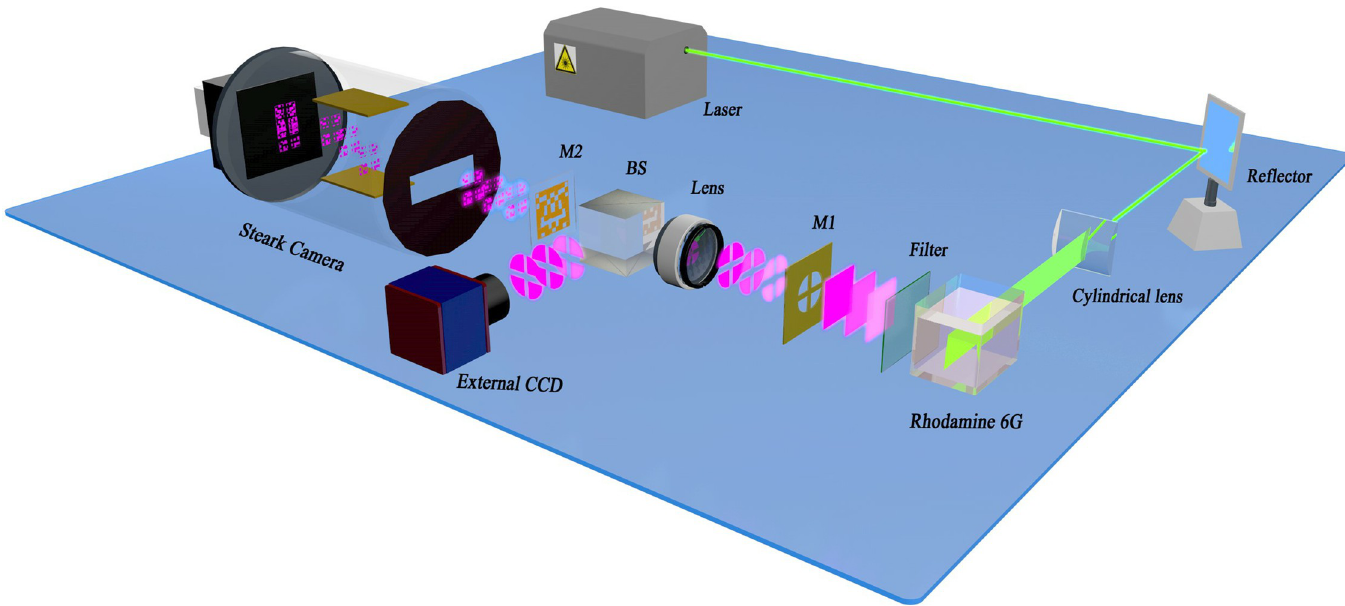
Fig 1. Schematic diagram of CUP-FLIM. M1: a pre-designed circular mask with a central cross; M2: the fixed binary mask; BS: beam splitter.